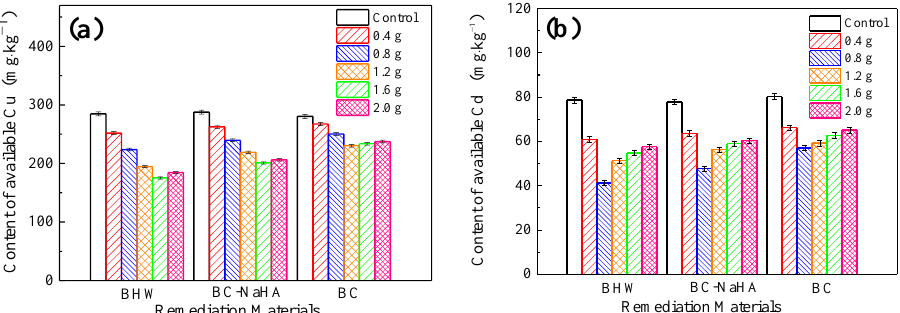
Figure 1. The effect of different restoration materials on the available copper ( a ) and cadmium ( b ) in the soil. the